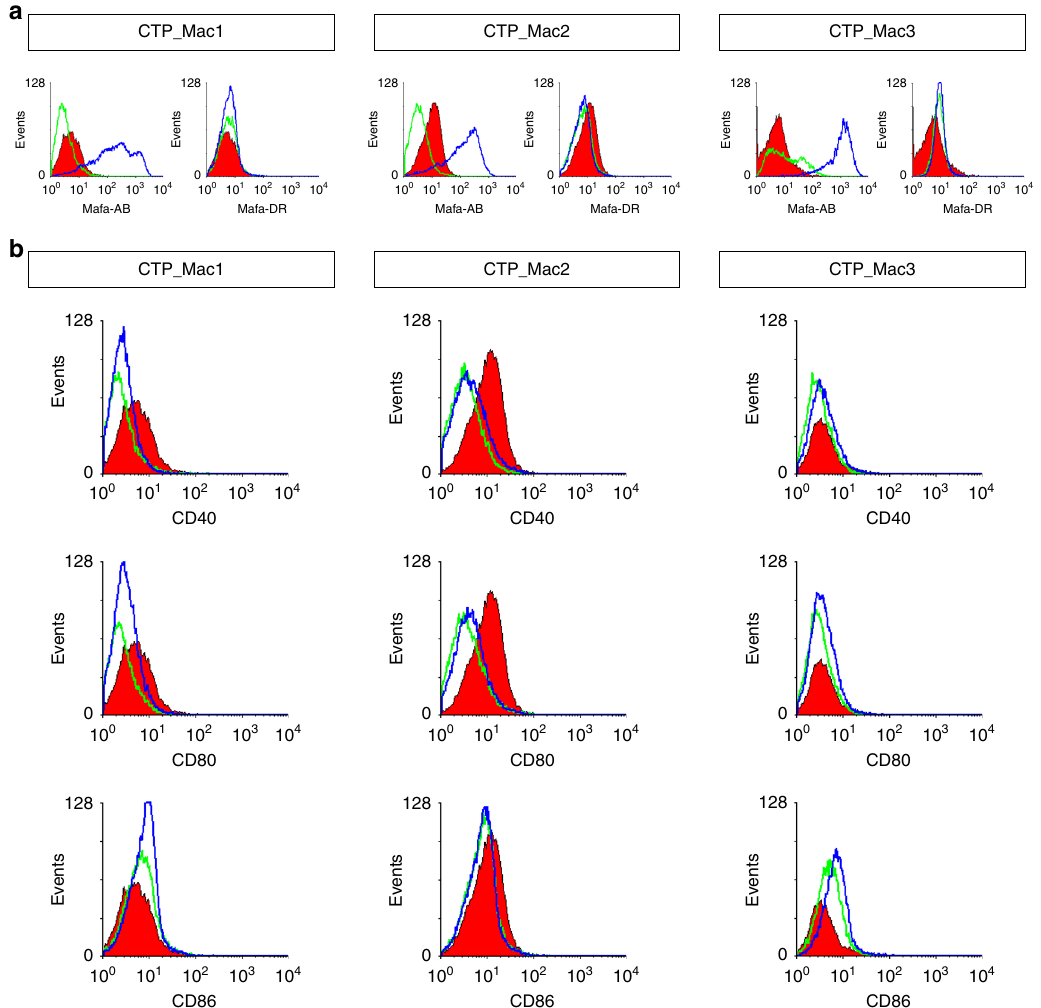
Fig. 3 Expression of immune-related surface antigens on CTPs. a Representative histograms showing the expression of MHC molecules by each batch of CTPs (Mafa-A Mafa-B counterparts of HLA-A and HLA-B, respectively and Mafa-DR counterpart of HLA-DR) and b costimulatory molecules (CD40, CD80 and CD86) on CTPs under normal culture conditions (Untreated- green histograms) or after exposure to IFN γ (100 ng ml − 1 , blue histogram) for 48 h prior to analysis. The red histogram represents the isotype